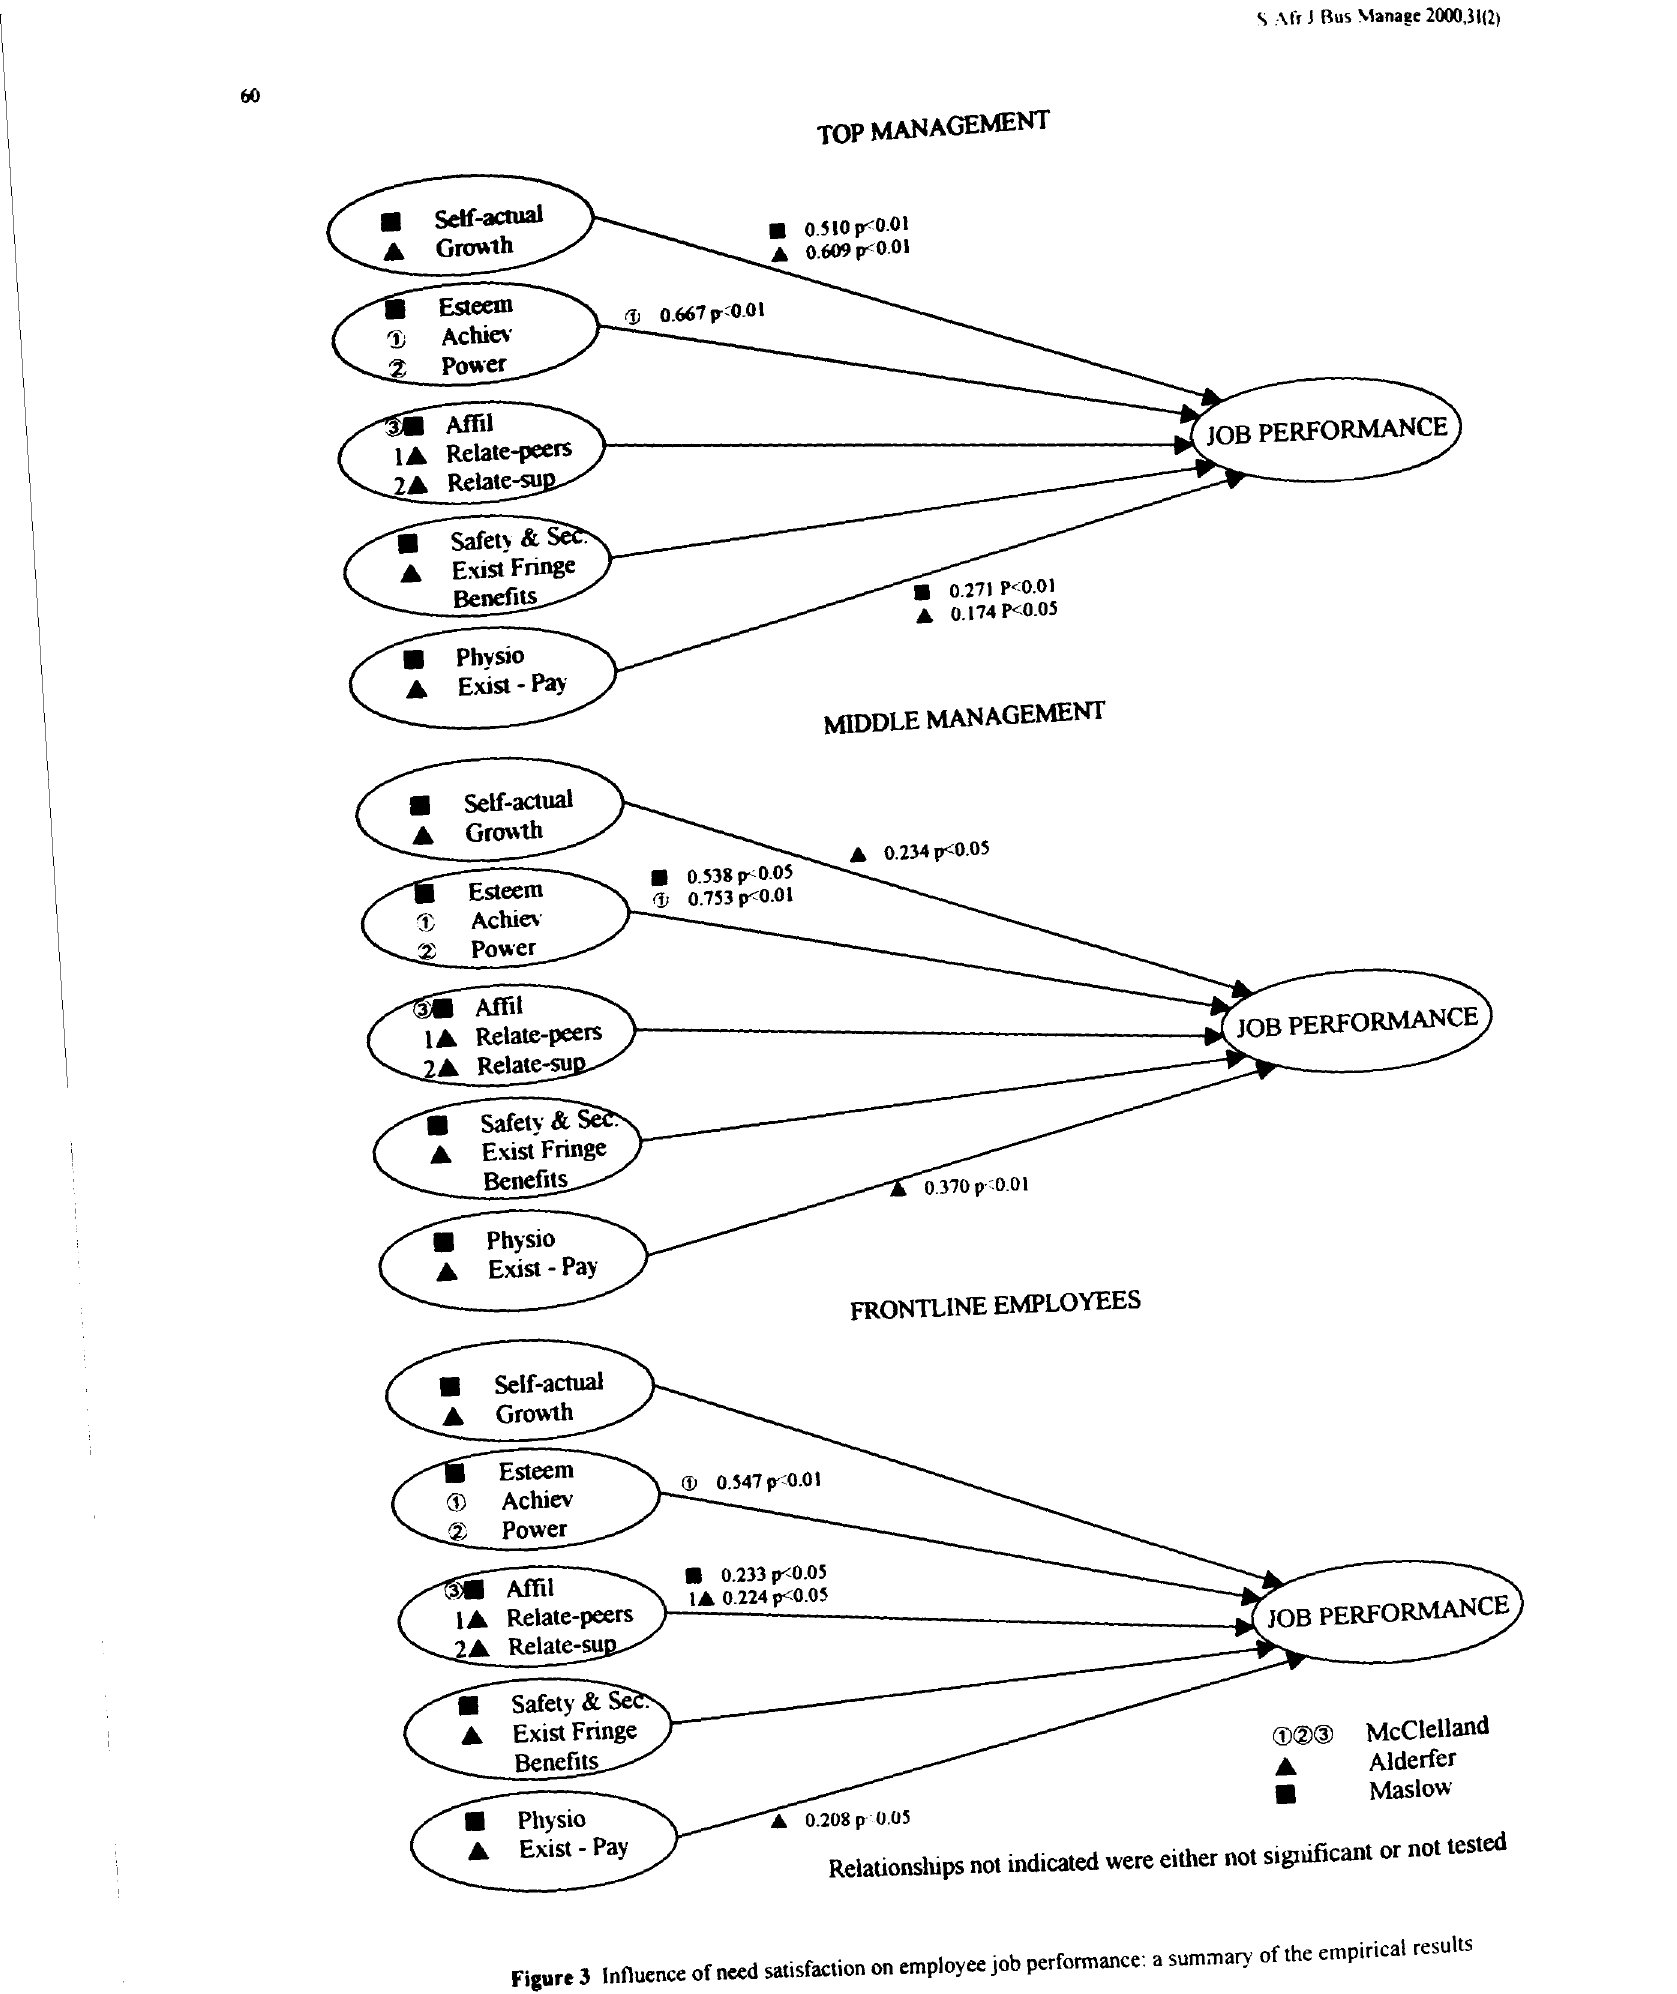
Figure 3 Influence of need satisfaction on employee job performance: a sum.nary of the empirical